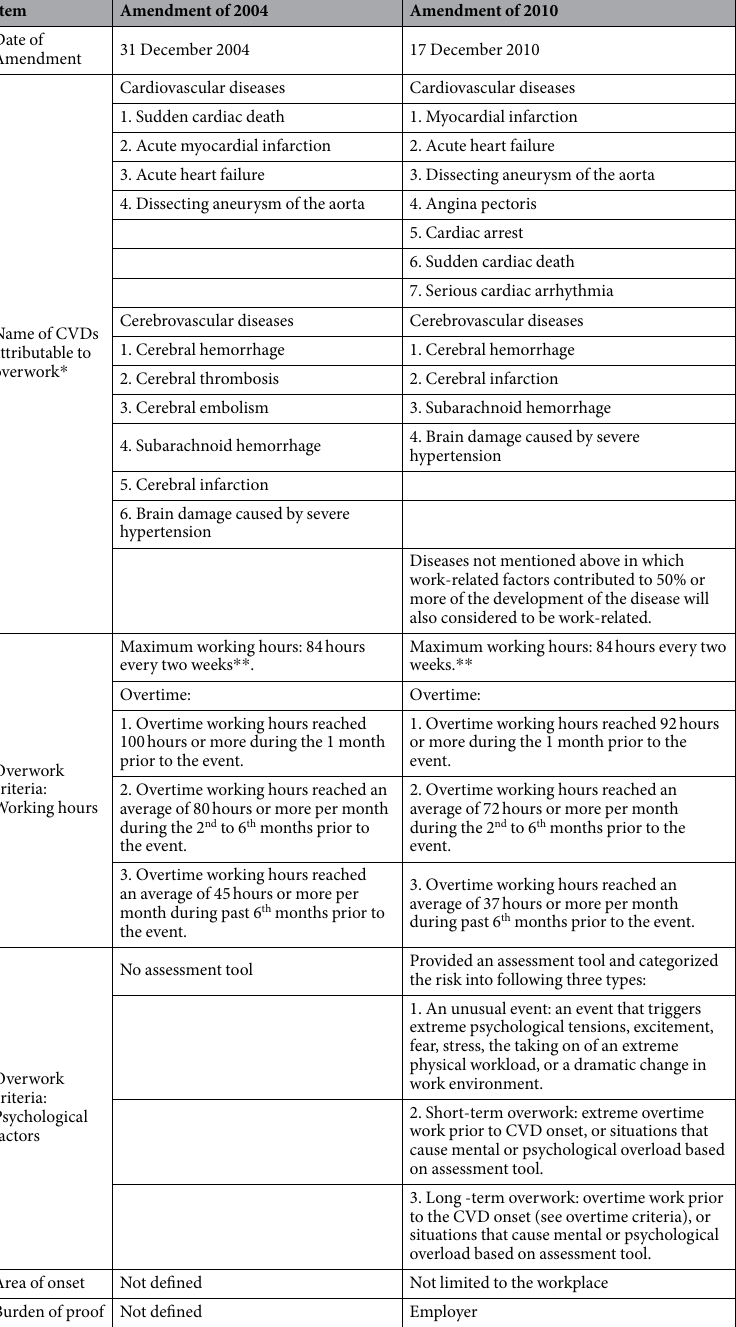
Our primary exposure measure was the implementation of new criteria for designating CVDs as overwork-related. (Table 1 describes the differences between the old and new criteria adopted in Taiwan.) According to the criteria, working hours and psychological factors were risk factors for devel- oping overwork-related CVDs. As working hours was a directly measurable indicator and the data were available